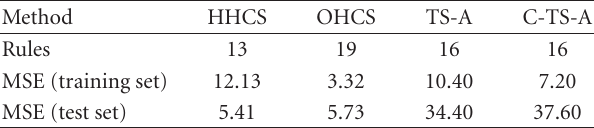
Table 4: Comparison with TS-A and C-TS-A methods. Method